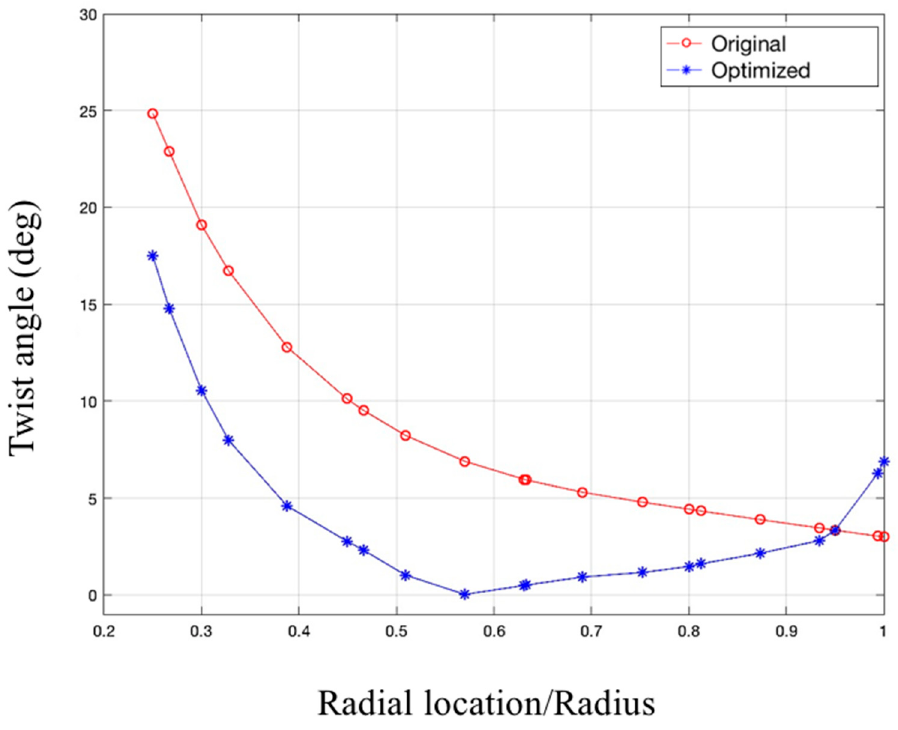
Figure 19. Comparison of twist angle distributions.